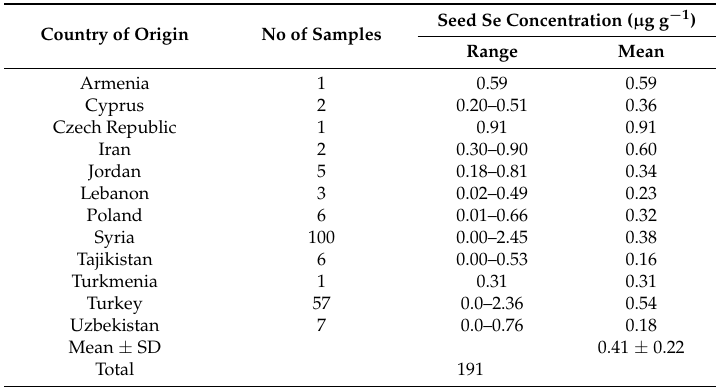
Table 4. Seed Se concentration of 191 lentil wild accessions grown in Lebanon.